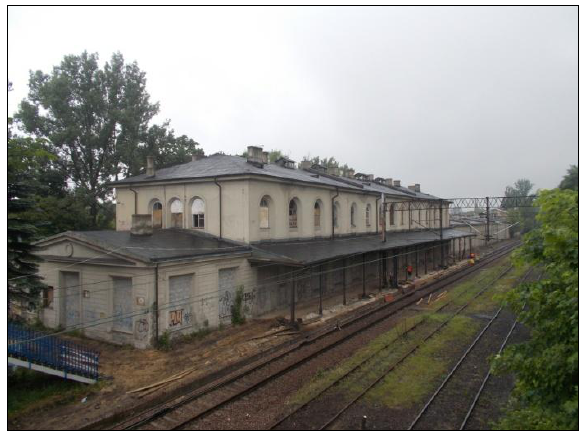
Fig. 7. The railway station in Maczki (Sosnowiec) in 2014 ( W. Dragan